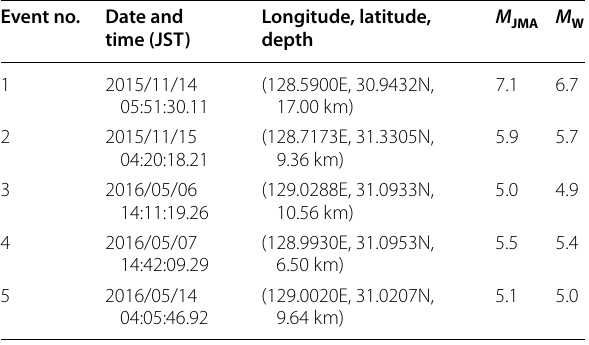
values w M JMA M